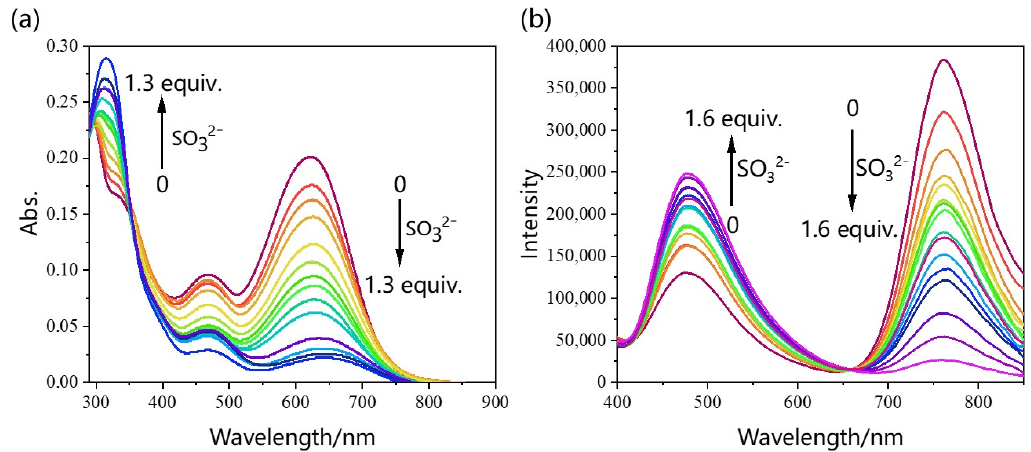
Figure 1. ( a ) UV − vis and ( b ) fluorescence spectra in response to different ions (λ ex = 300 nm, slit: 5 nm/5 nm, 5 μM for fluorescence and 50 μM for UV − vis).